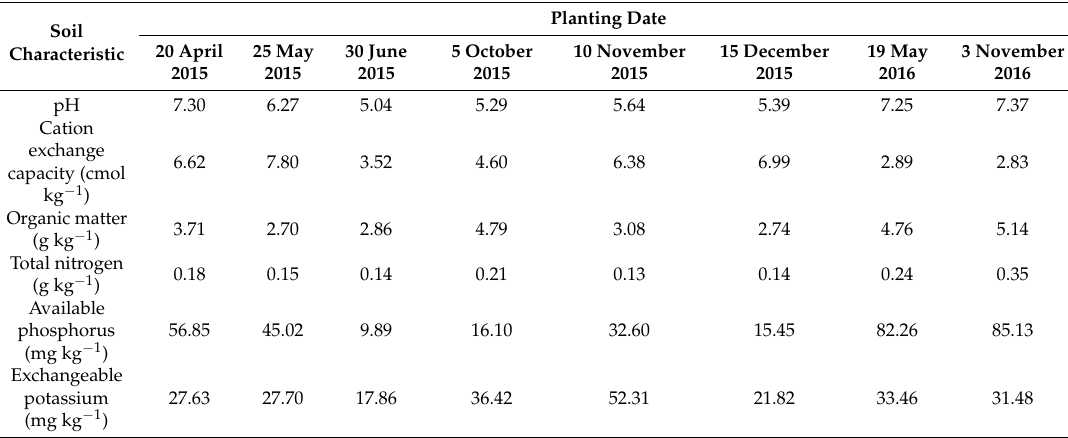
Table 1. Soil properties at a depth of 0–30 cm of the experimental plot for the eight planting dates. Soil